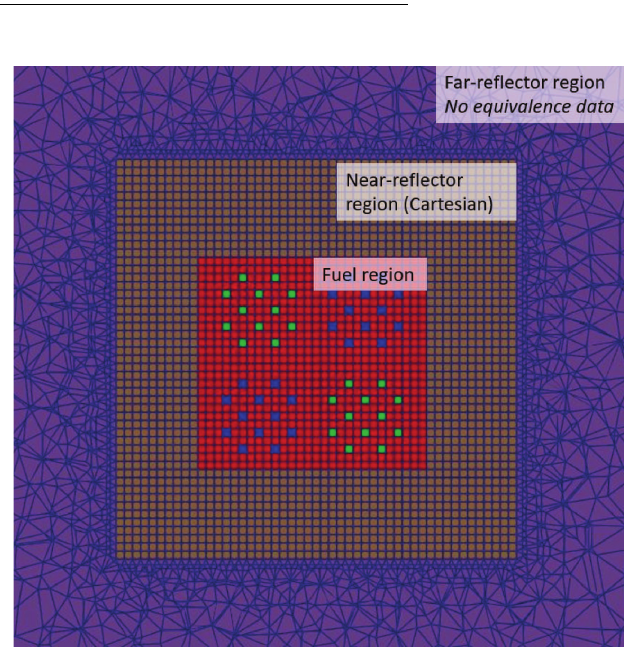
Fig. 2. Top-view cross section of Griffin